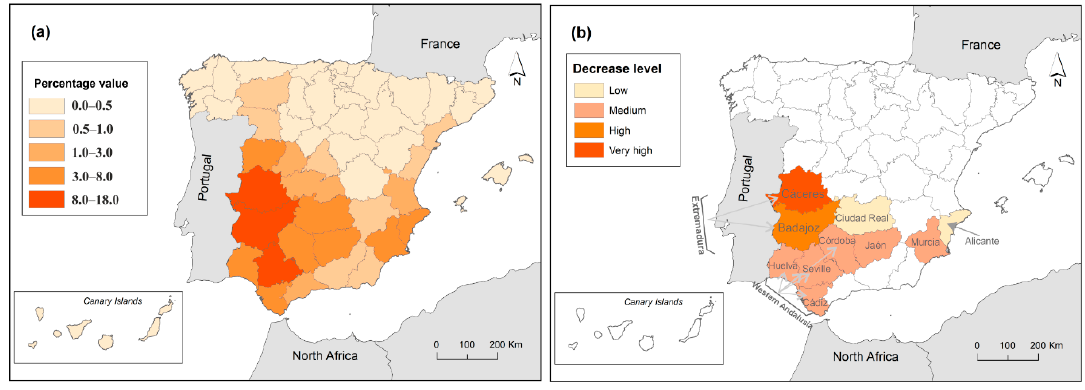
Figure 4. ( a ) Percentage of deaths in each Spanish province with respect to national total for 1916–1930. ( b ) Provincial rate of regression of number of deaths in each Spanish province with respect to the total in the whole of Spain.